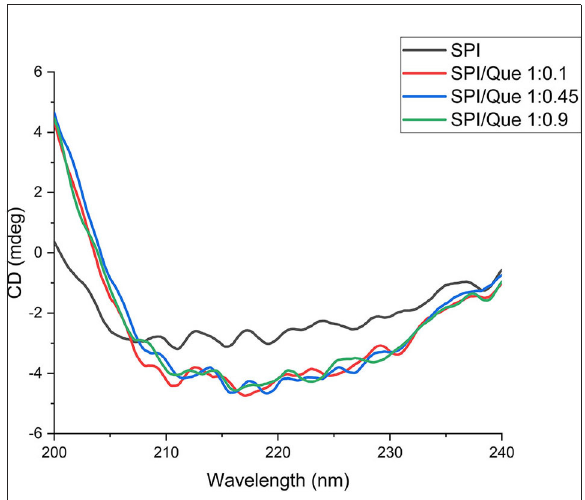
FIGURE4 Circular dichroism spectra of SPI and SPI-quercetin complexes with different molar ratios (1:0.1, 1:0.45, 1:0.9) in the wavelength range of 200–240nm.